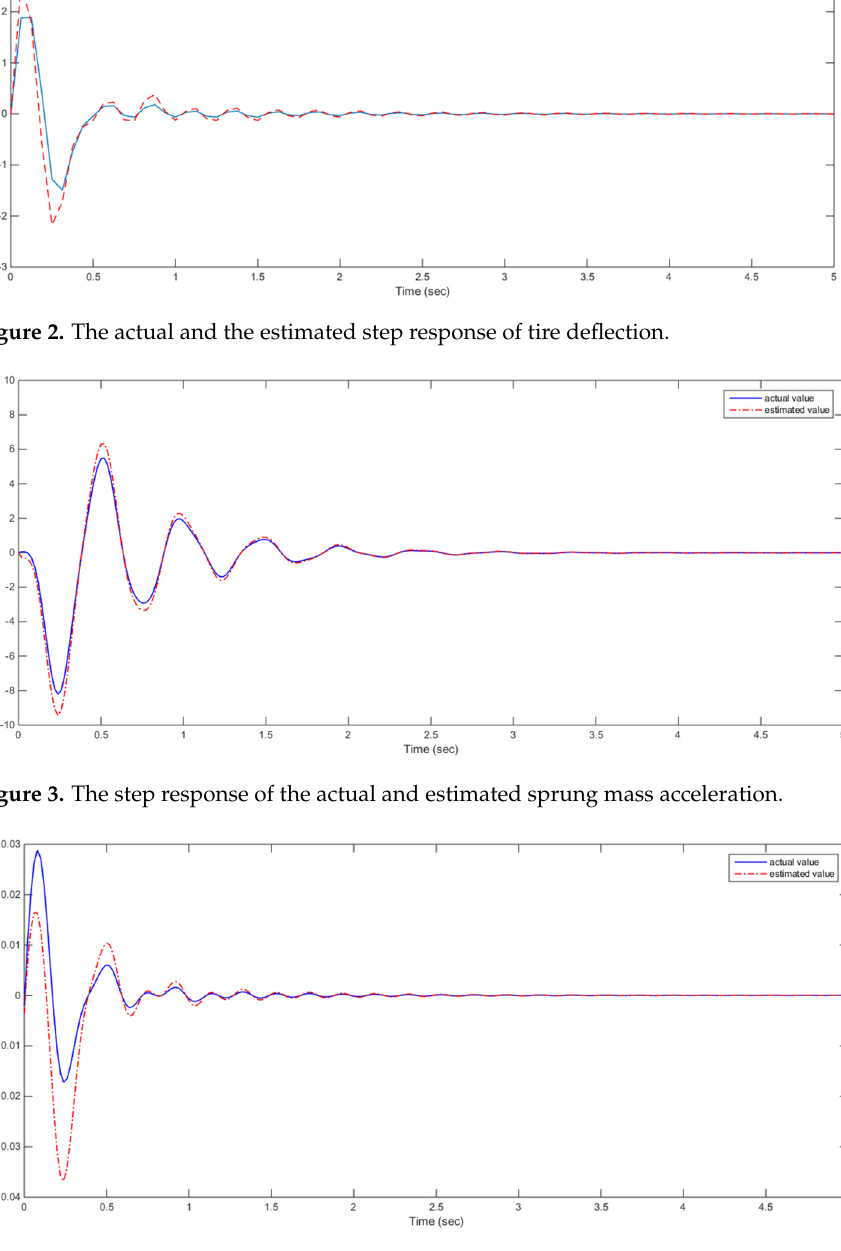
Figure 5. The control signal. Figures 6 and 7 present the fault estimation results, which show that the stability of the closed-loop system is guaranteed under external disturbances and sensor faults. The estimation results show that the proposed methodology has excellent estimation per- formance and efficiently tolerates sensor faults.